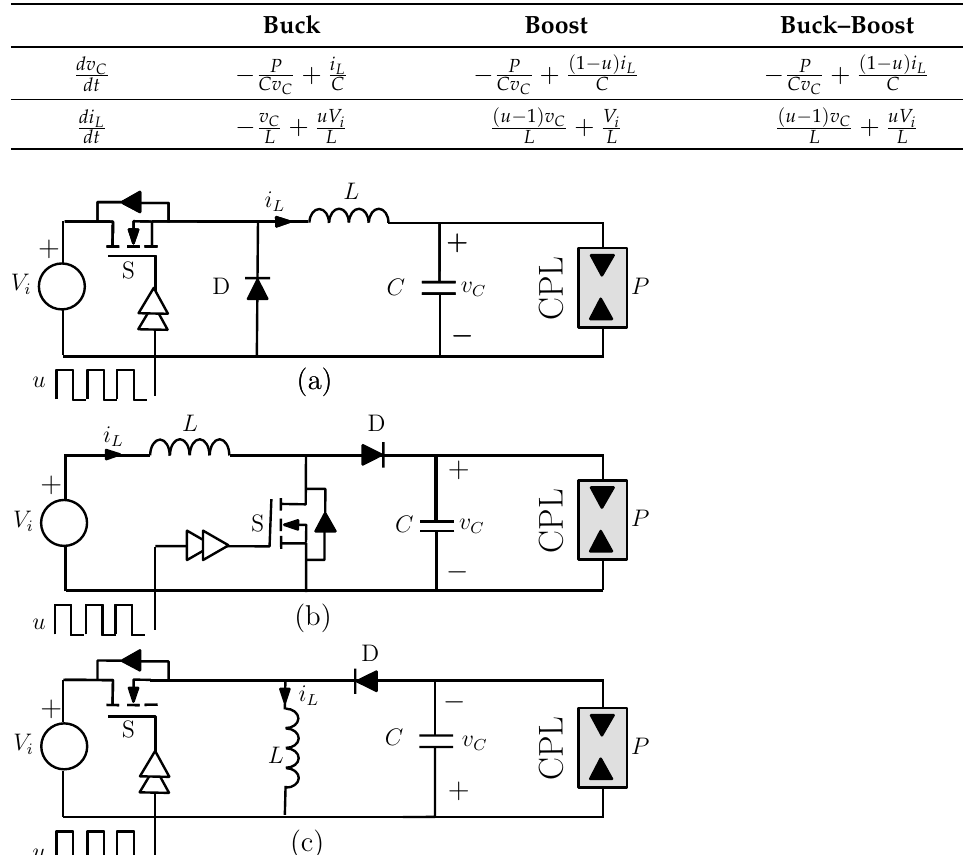
Table 2. State equations for the three elementary converters with a CPL.